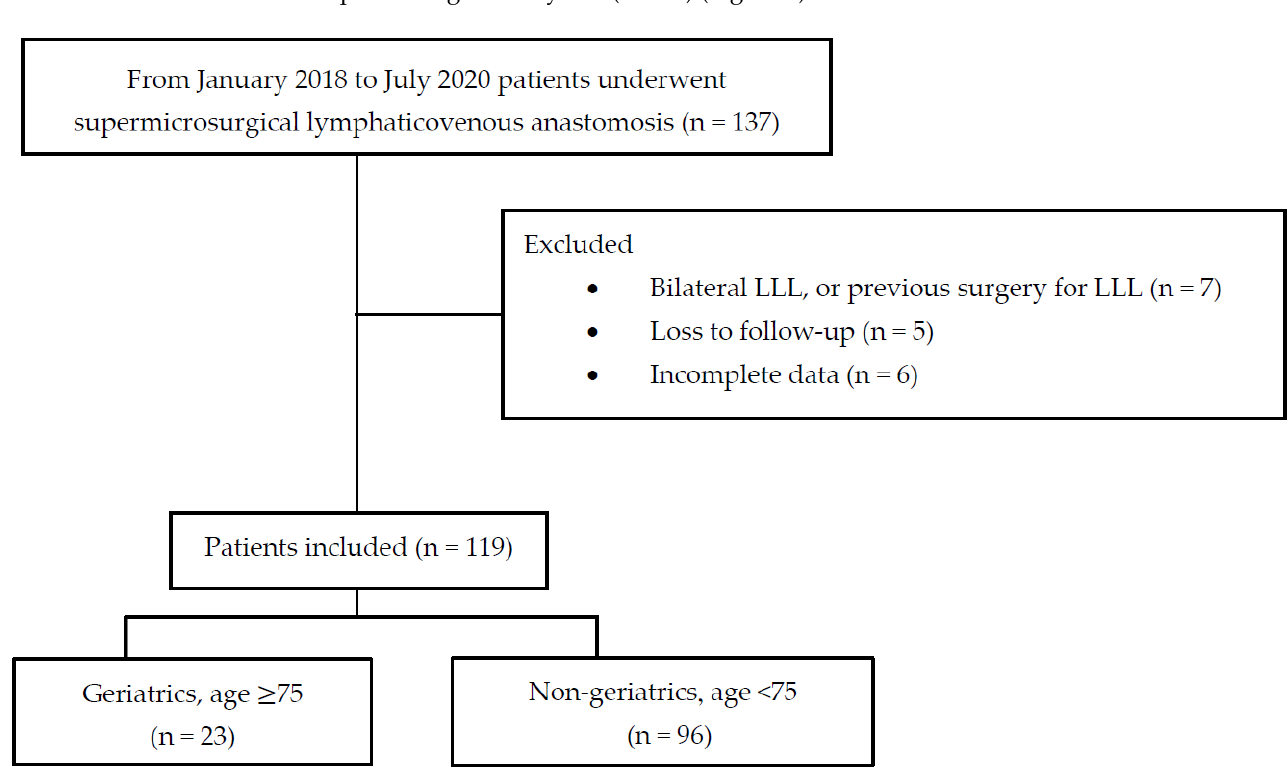
Figure 1. Flow diagram of case selection. LLL, lower limb lymphedema.